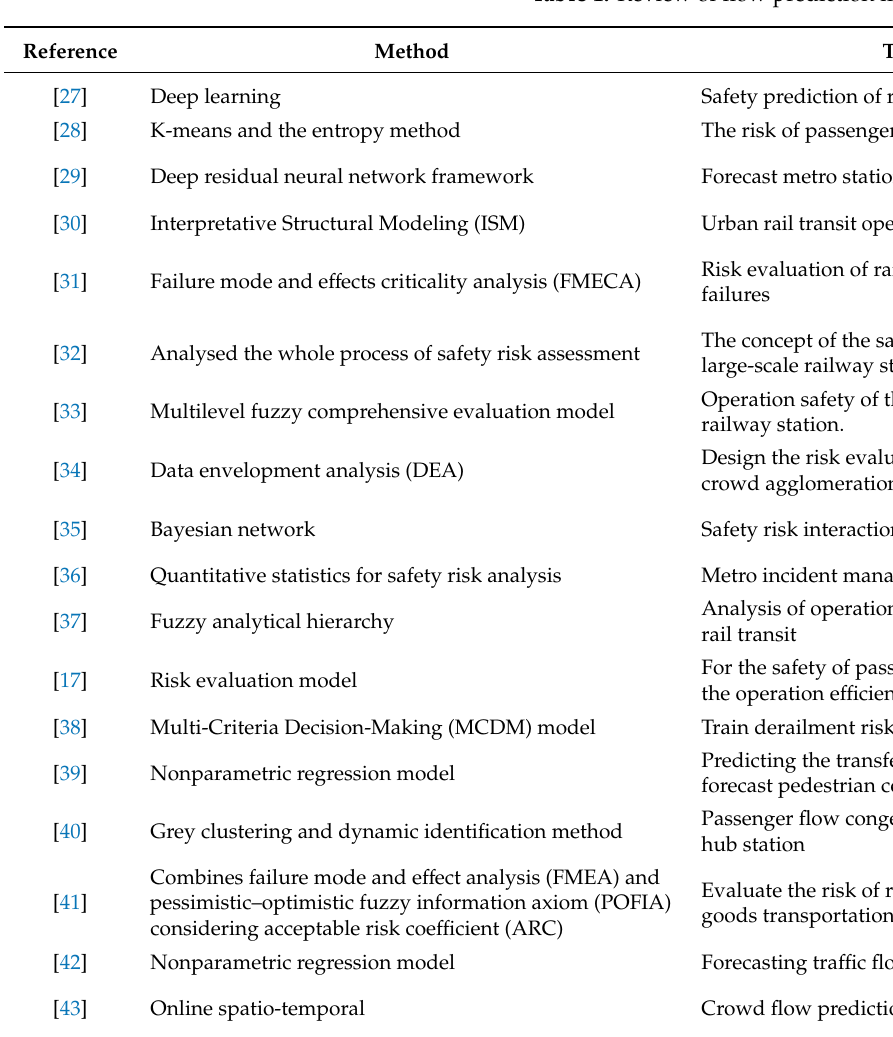
Table 1. Review of flow prediction methods from previous